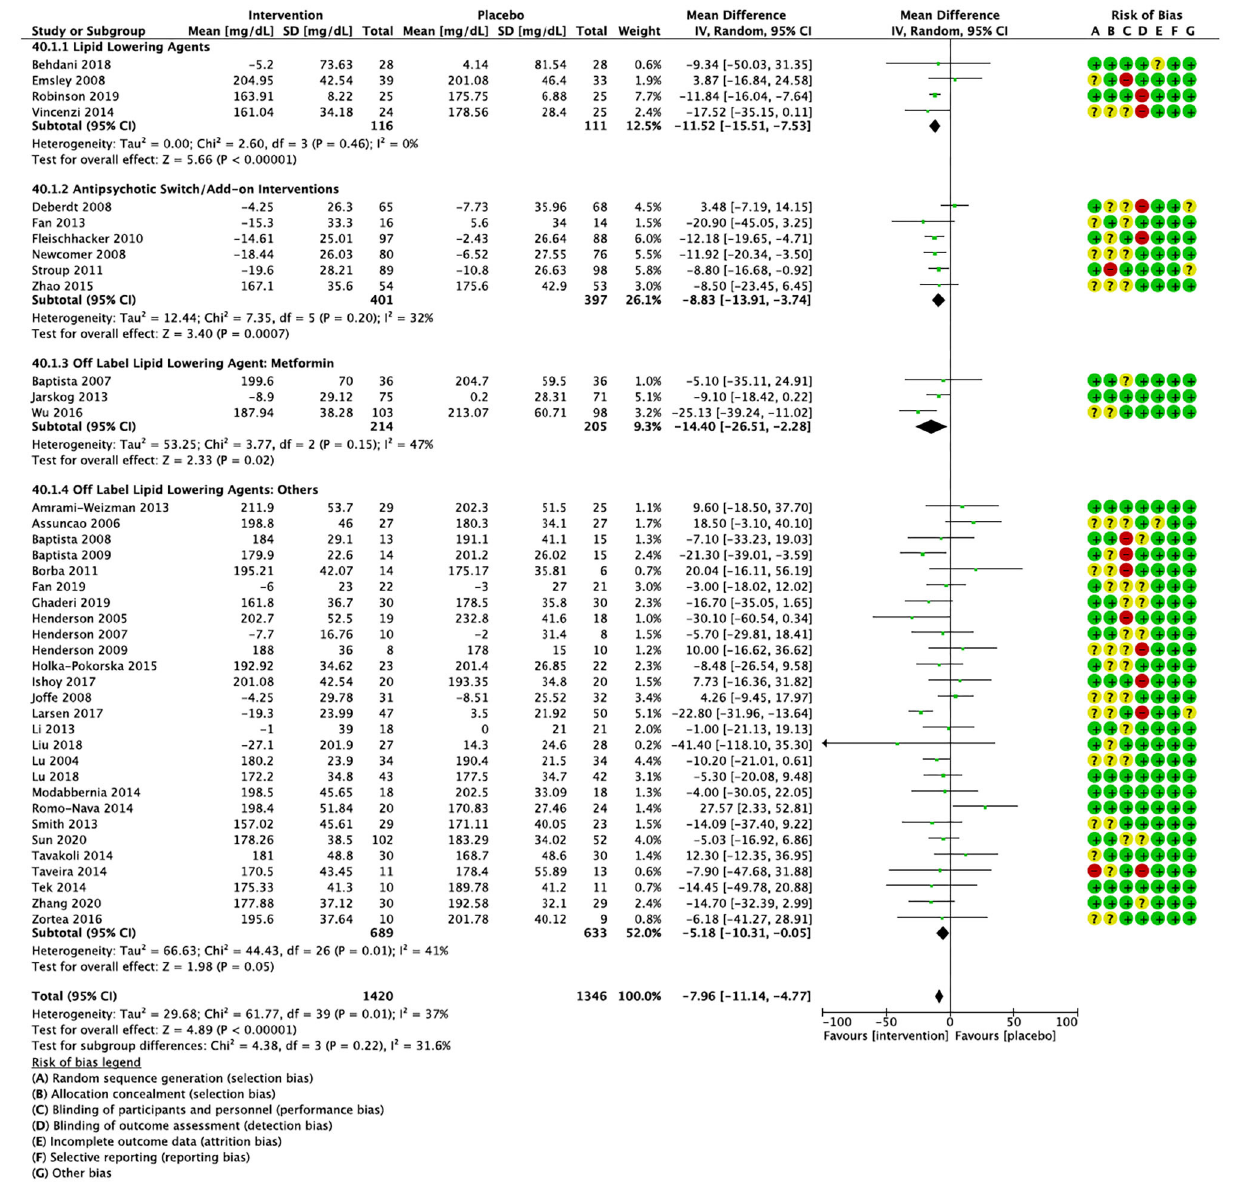
FIGURE 6 | Forest plot showing the pooled mean difference in changes in total cholesterol (mg/dL) for all interventions as compared to placebo along with subgroup analyses and Risk of Bias